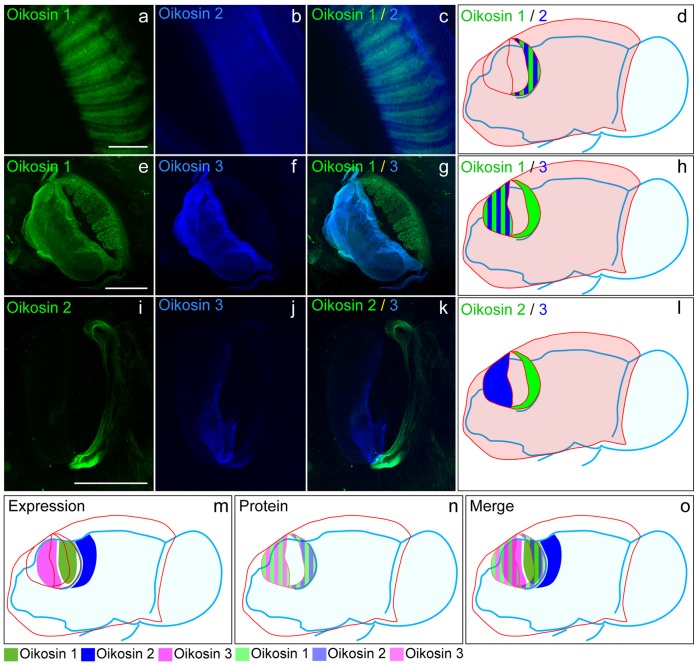
Localisation of oikosins 1, 2 and 3 in the fcf (food-concentrating filter) in pre-house rudiments.Panels in the top row (a-c) display co-staining of oikosins 1 and 2 in the inflating fcf, (anterior to upper left). Scale bar: 10 µm. Panels in the middle rows (e-g and i-k) show co-staining of oikosins 1 and 3, and oikosins 2 and 3, respectively (anterior to left), in the nascent secreted pre-house. Scale bars: 100 µm. d, h, and l) Cartoons illustrating the location of the stained structures in the pre-house rudiment (pink) superposed on an outline of a lateral view of the animal (blue), anterior to the left. Striped regions indicate regions of antibody co-staining. In the bottom panels the composite mRNA expression domains (m, dark shades) and protein localization in the rudiment (n, translucent pastel shades) of oikosins 1,2 and 3 are shown as well as a merged view of both (o).